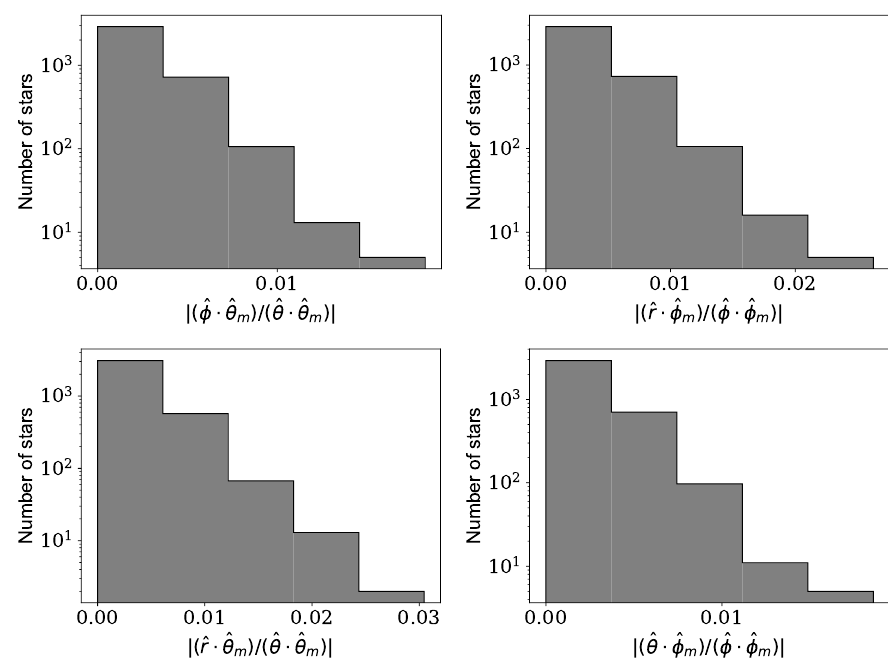
Figure A1. The ratio of the dot products of the unit vectors in the spherical coordinate system for the stars that belong to the Fornax dSph as reported by Gaia. The figure indicates that all of the ratios are negligible for any of the